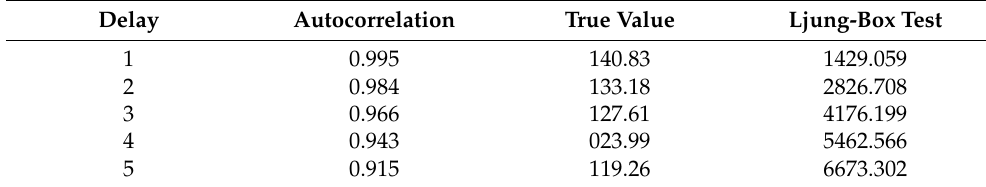
Table 1. Correlation analysis of power load in five adjacent time steps.